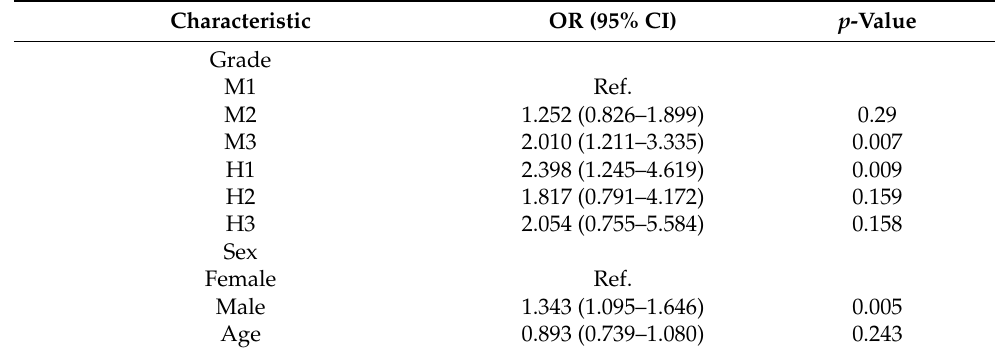
Table A2. Odds ratios for self-perceived PLMS in participants without restless leg